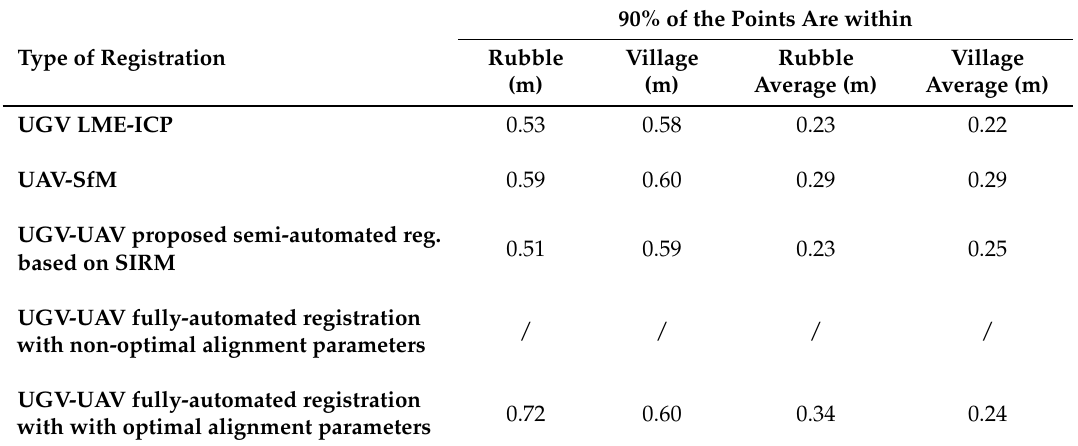
Table 5. Quantitative representation of the point to point evaluation for the semi-automated 3D registration and the fully automated 3D registration systems (both scenarios Rubble, Village). Type of Registration Rubble